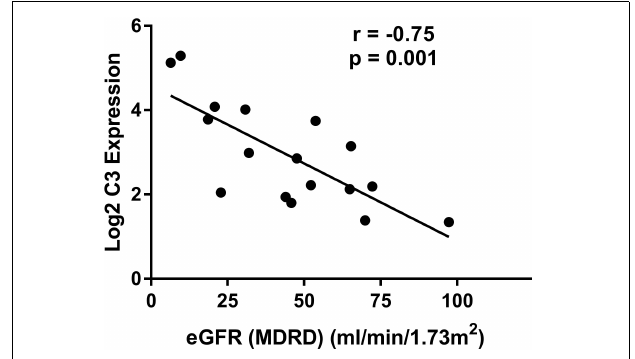
TABLE 3 | Baseline data of 54 DN patients in the stable and progressive